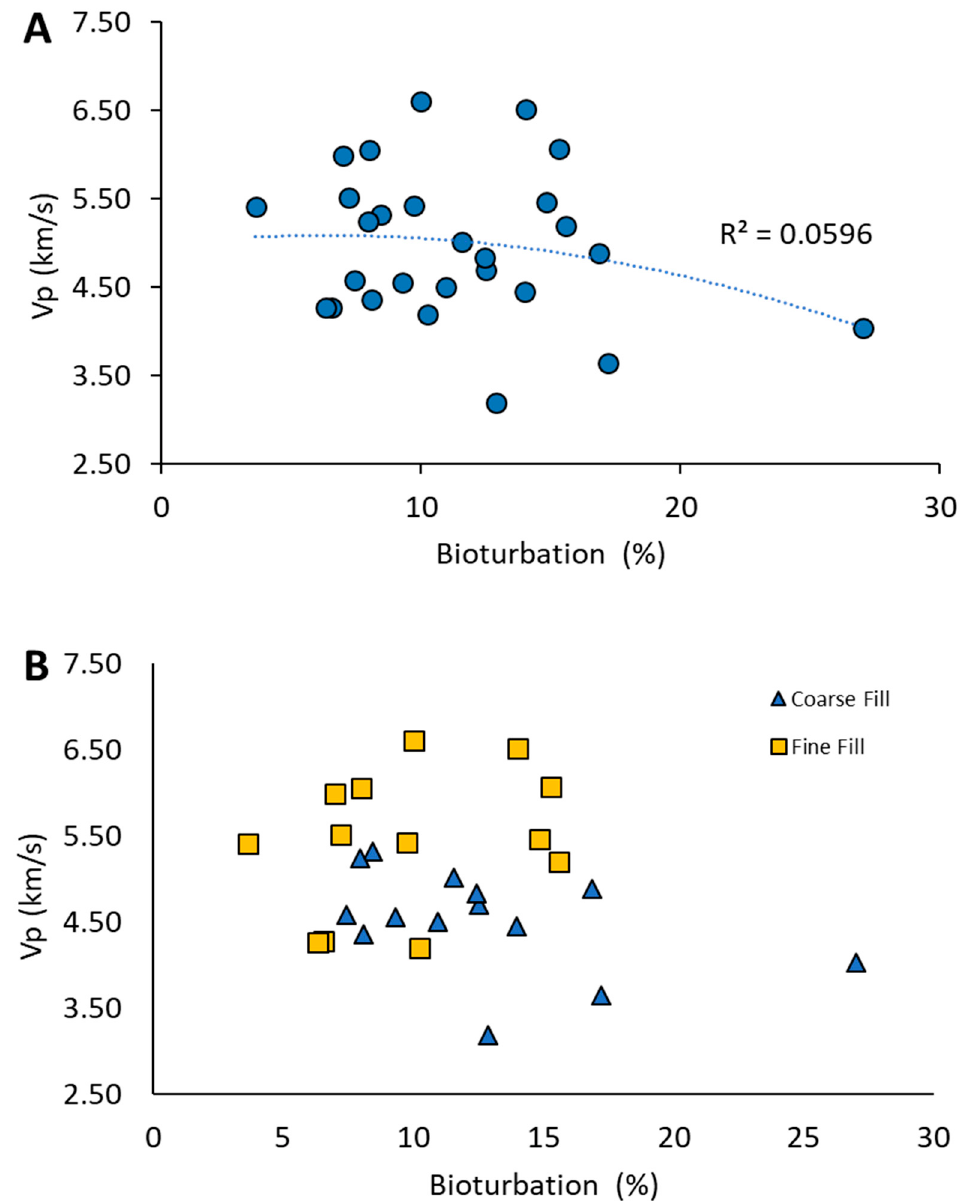
Figure 13. ( A ) Compressional velocity (V P )–bioturbation intensity cross plot showing the weak relation. ( B ) V P –bioturbation intensity relation with burrow filling material superimposed, and showing that fine-filled burrows have higher velocities than coarse-filled burrows.